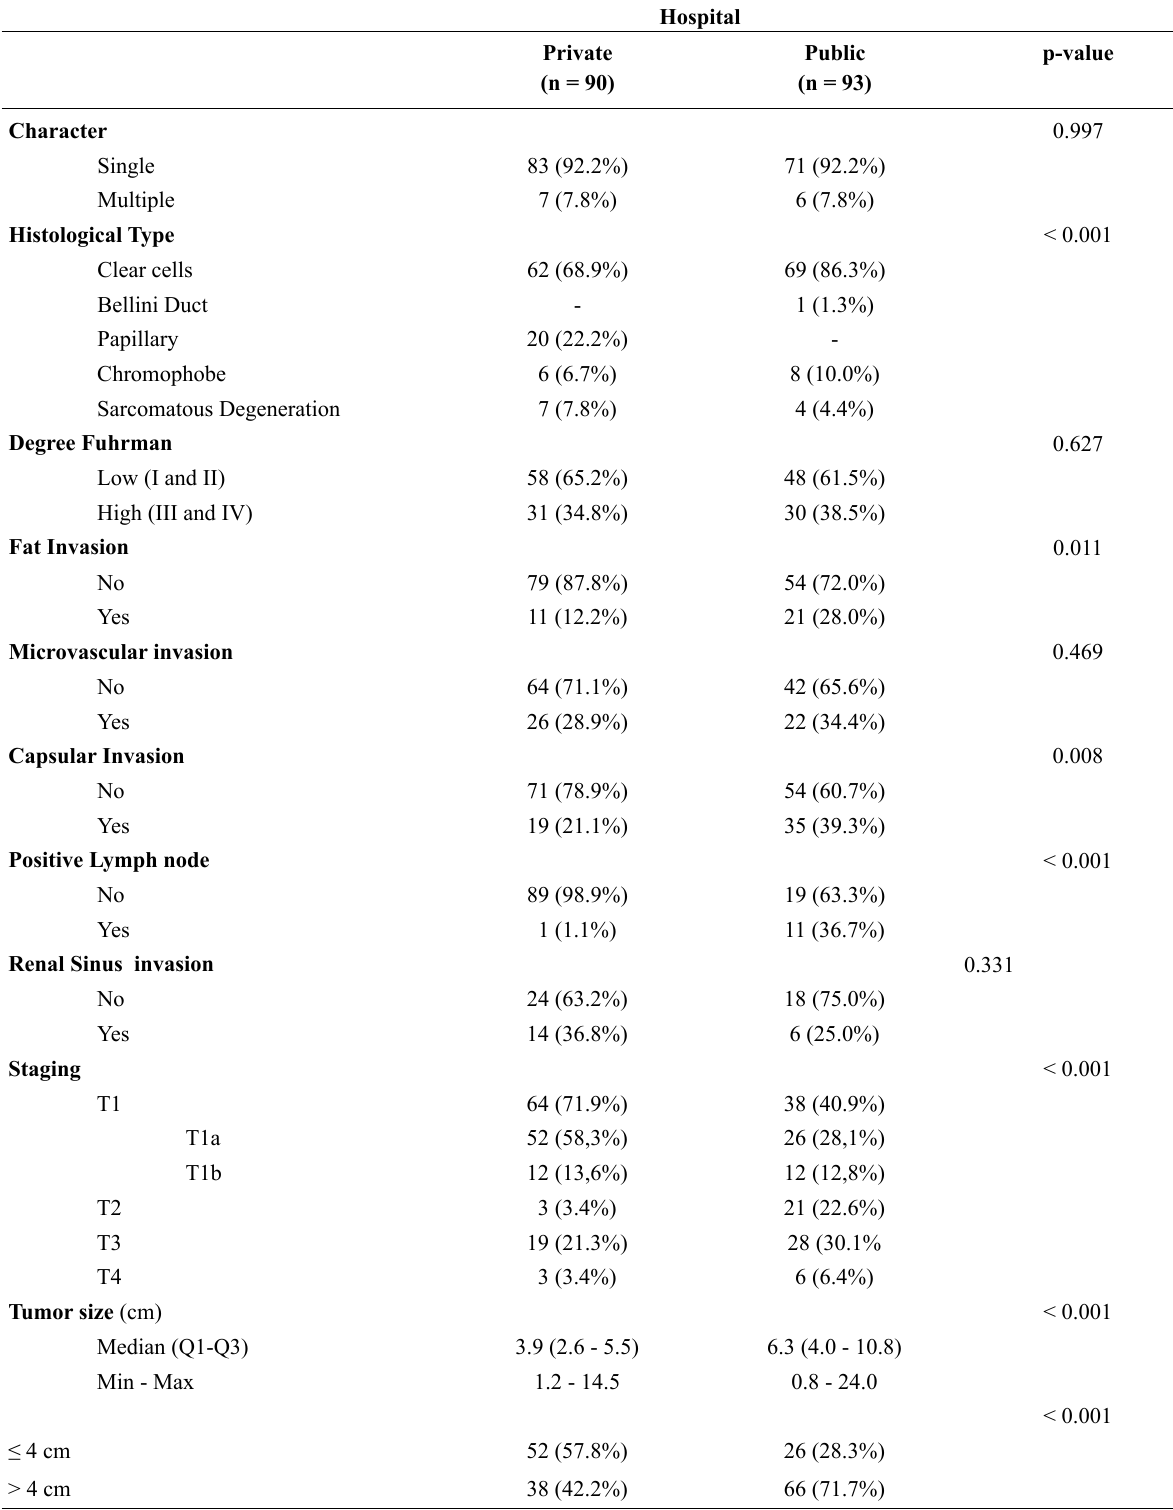
Table 4 - Pathological